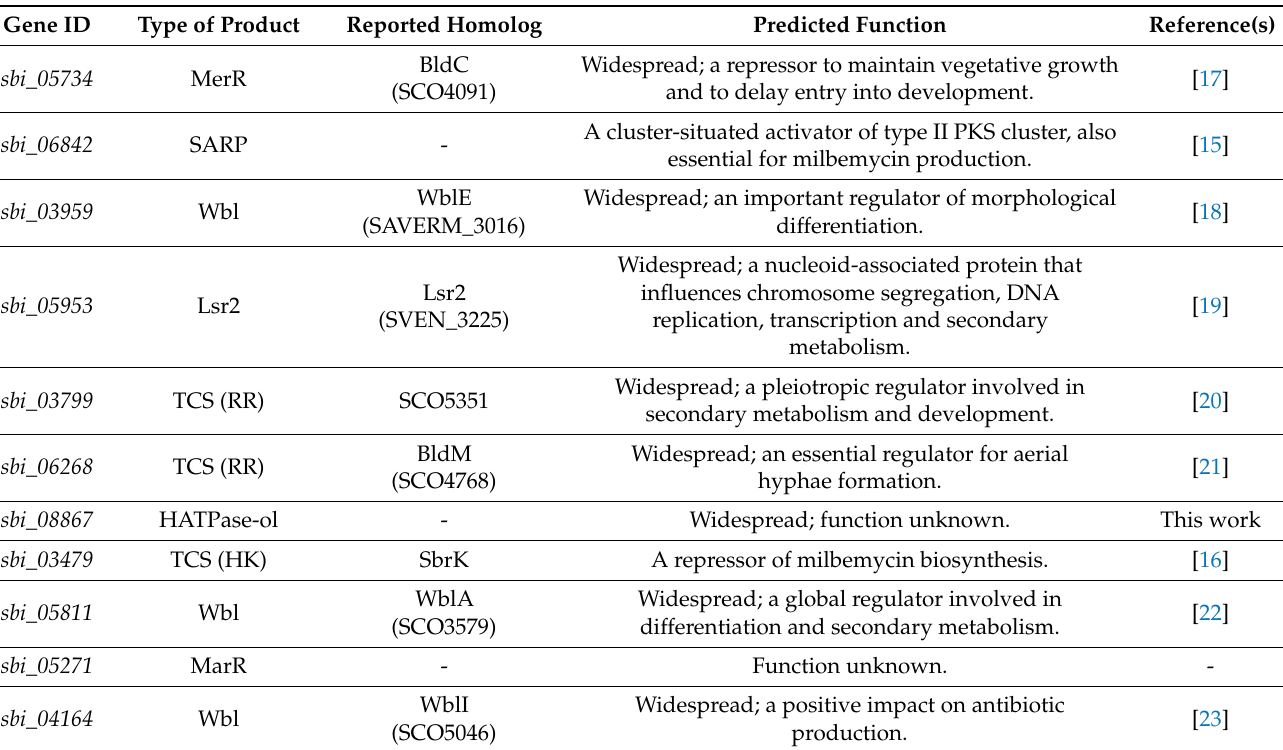
Figure 1. Identification of SBI_08867 in S. bingchenggensis . ( a ) Transcript abundances of genes with FPKM values higher than 2000 measured by RNA-seq on day 3. ( b ) Predicted domain structure of SBI_08867. HATPase, histidine kinase-like ATPase. ( c ) Amino acid sequence alignment of SBI_08867 and its orthologs. Identical or similar residues in all sequences are highlighted in blue and orange, respectively. The corresponding assumed conserved motifs are marked in red. SCO1241, SBI_08867 or- tholog from S. coelicolor ; SAVERM_7097, SBI_08867 ortholog from S. avermitilis ; SGR_6286, SBI_08867 ortholog from S. griseus . Table 1. 11 candidate transcriptional regulatory genes with high FPKM values (FPKM > 2000) on day 3.